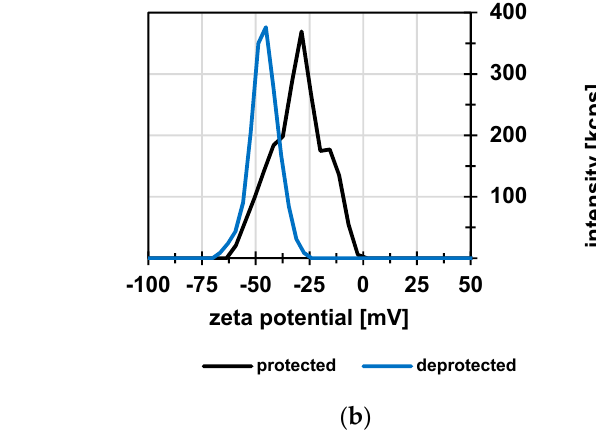
Figure 3. Comparison of protected and deprotected particles: ( a ) size; ( b ) zeta potential (kcps = kilo counts per seconds); data are shown for one of the three independent measurements (Table 1).